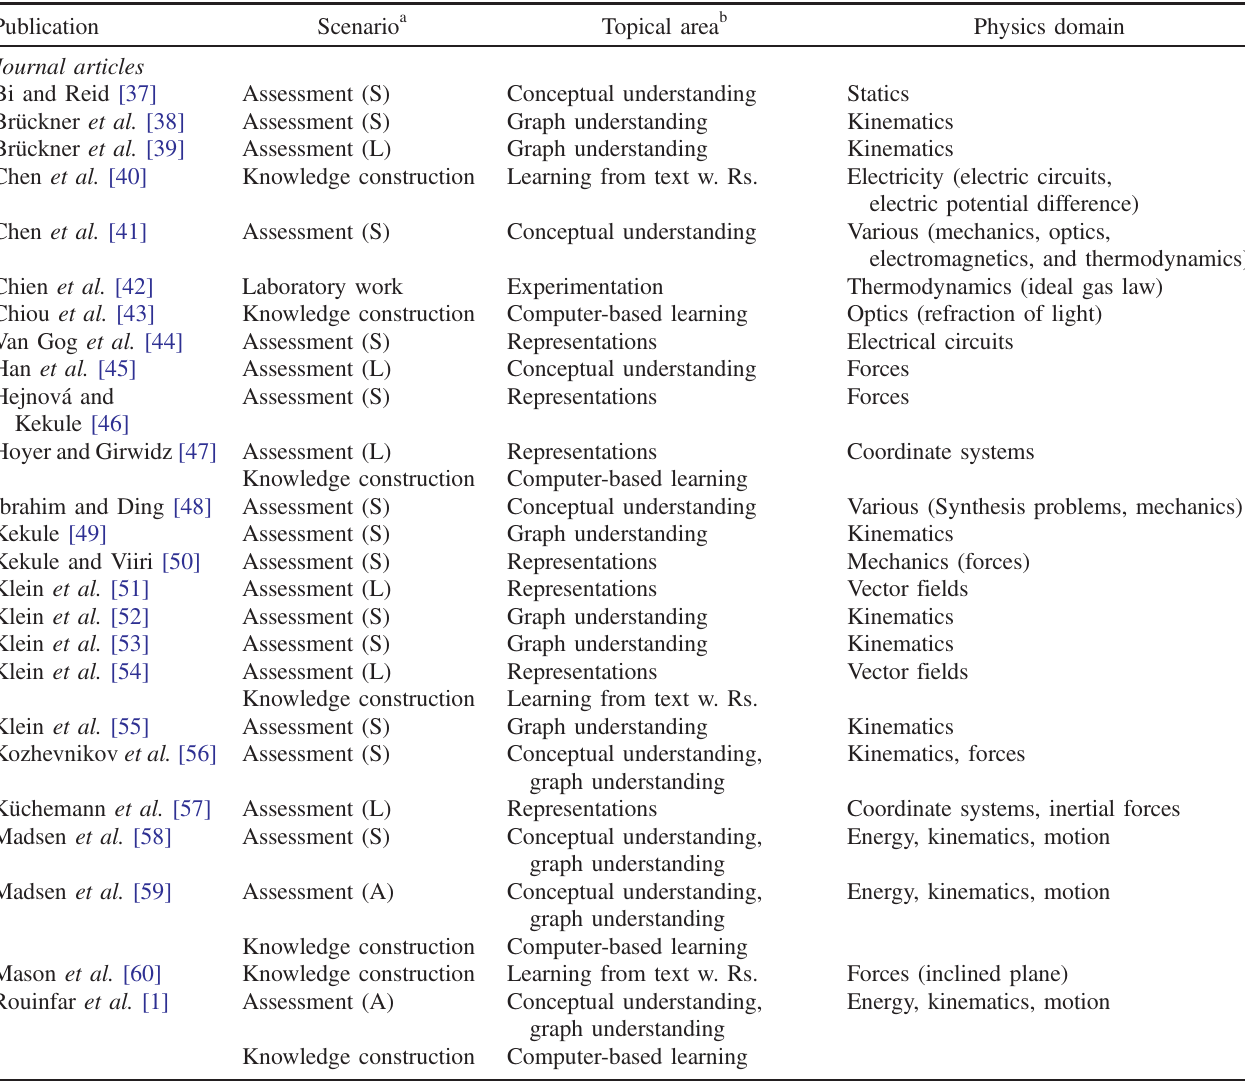
TABLE VII. Dissemination of eye-tracking studies in physics education research: